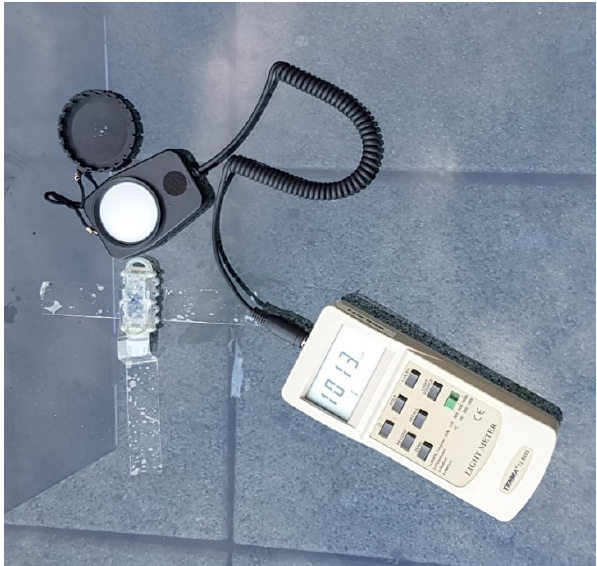
Figure 16. Light measurement calibration of AquaBit.